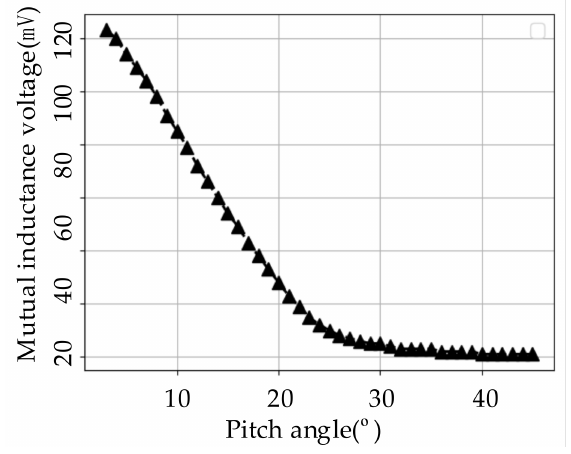
Figure 7. Mutual inductance voltage measurement value of group 1 coil in pitch range of 3 ◦ –60 ◦